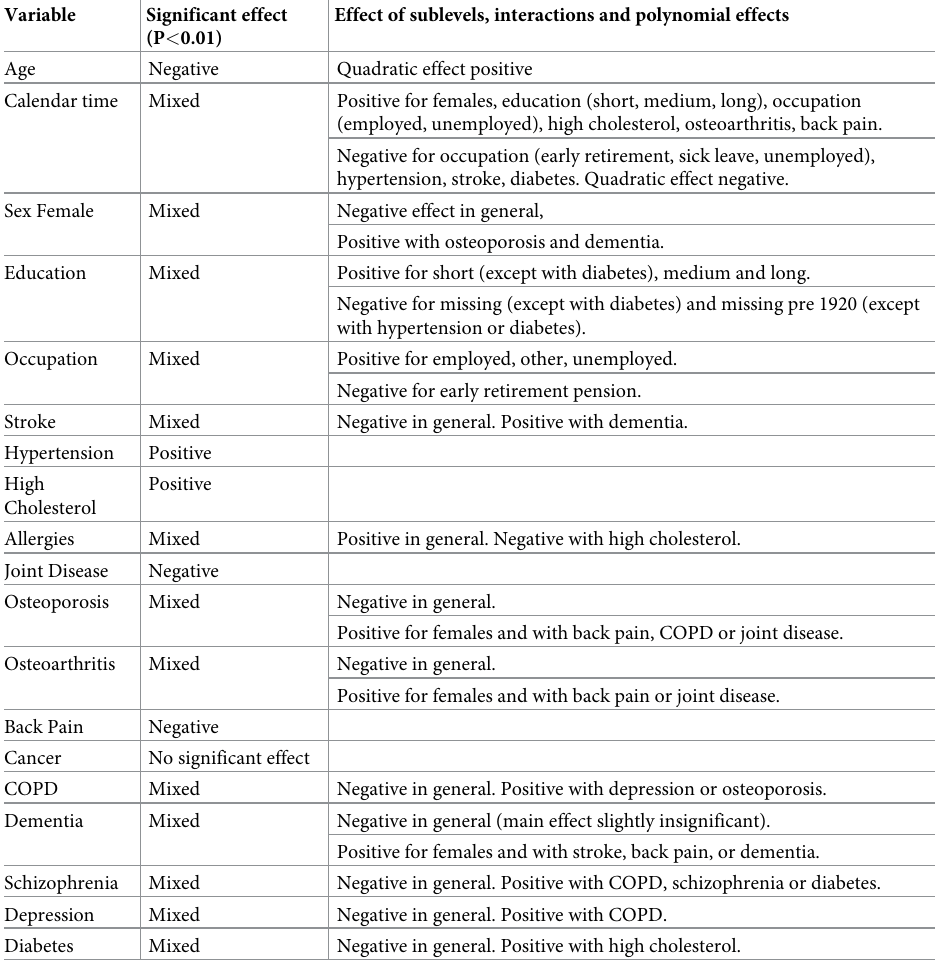
Table 5. Effects for statistical significant explanatory variables on the postponement time until the next disease diagnosis. Positive and negative effects correspond to increased and decreased diagnosis postponement